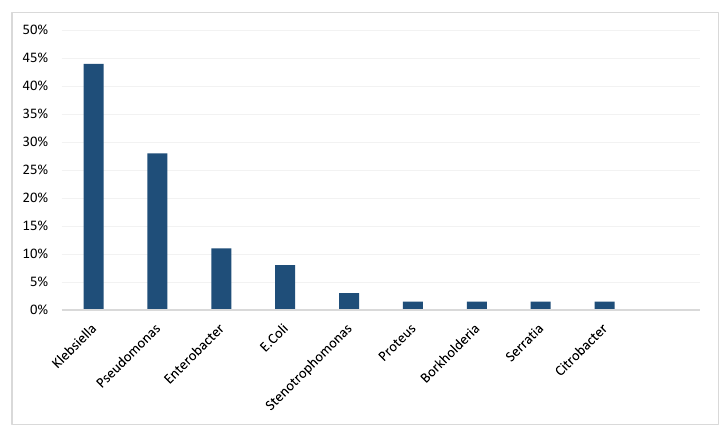
Figure 4 . Prevalence of various organisms in people with catheter infection with gram-negative